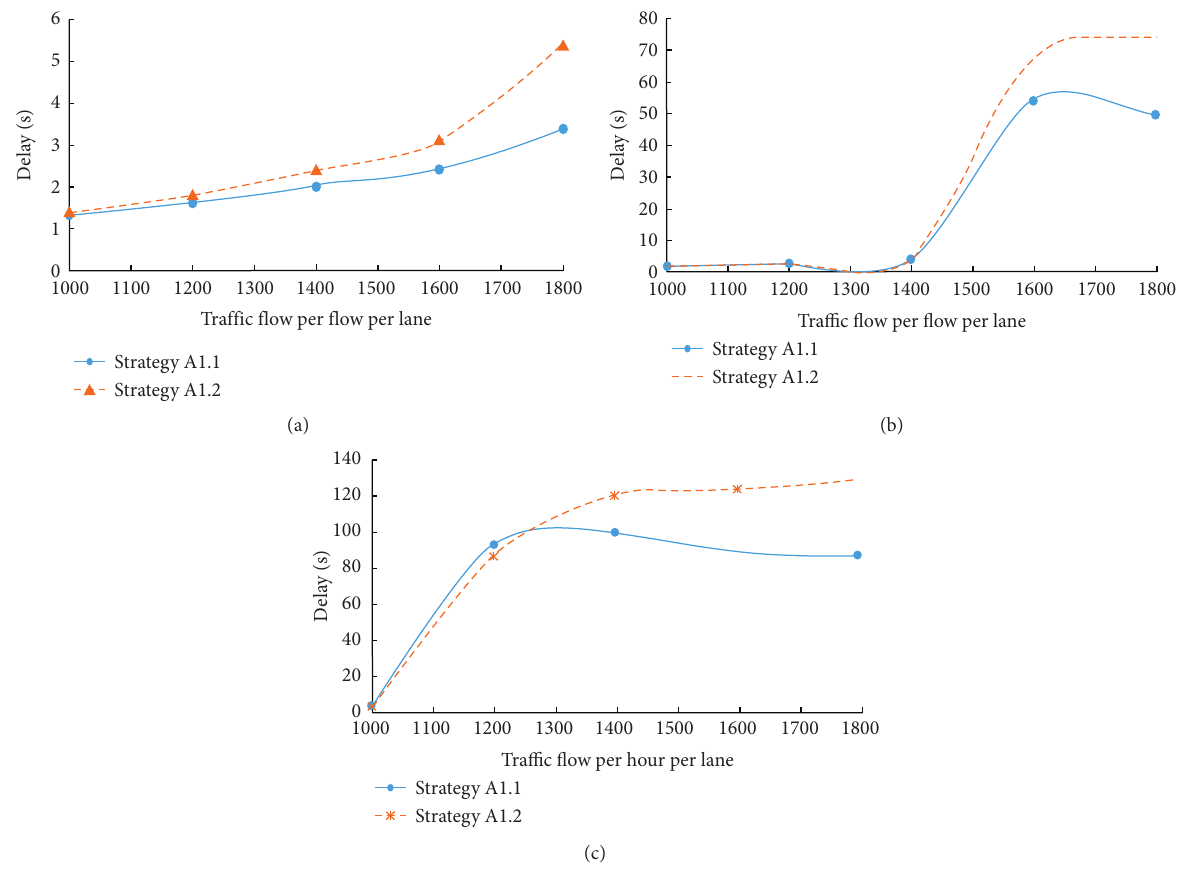
Figure 7: The average vehicle delay change curves of strategy A1.1 and strategy A1.2 at different off-ramp flow. (a) 20%. (b) 30%. (c)